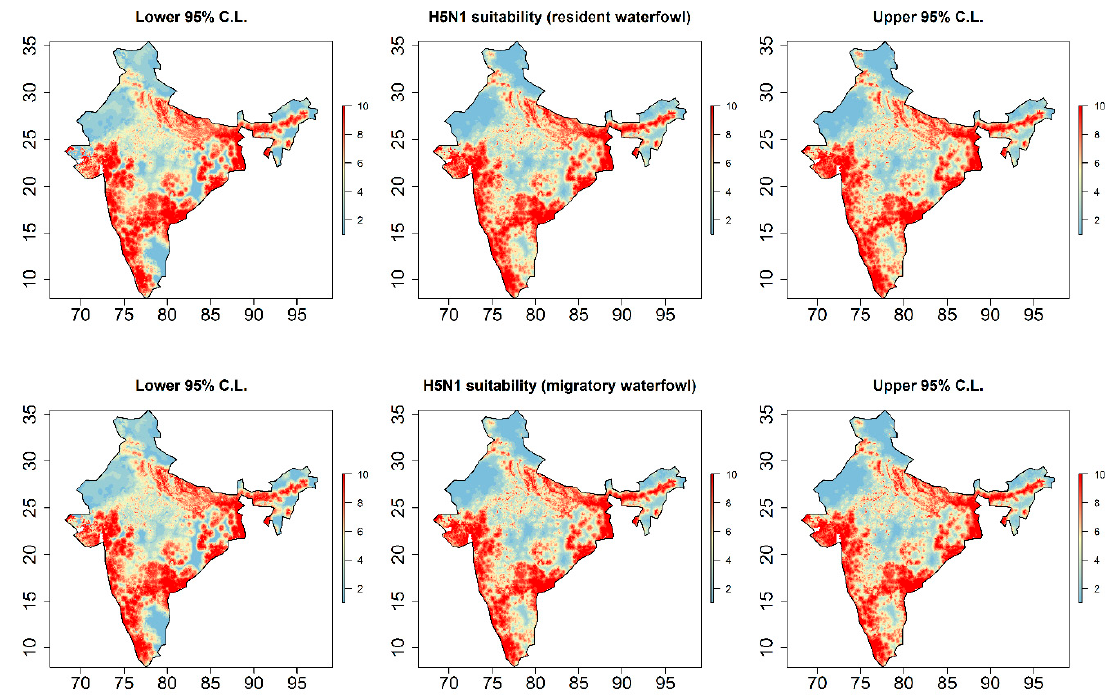
Figure 3. Highly pathogenic avian influenza (HPAI) virus, subtype H5N1, landscape suitability based on predicted intensity at 2.5 arc-minutes (approximately 5 km). The center panels depict HPAI H5N1 suitability for resident-specific ( top ) and migratory-specific ( bottom ) waterfowl models as deciles of the predicted intensities from the best fitting and performing inhomogeneous Poisson point process models (Table 1; Table S3). The left and right panels depict the lower and upper 95% confidence limits, respectively, for the predicted intensities. Map axes represent degrees of longitude ( x -axis) and latitude ( y -axis). All maps are displayed only for the purposes of depicting the distribution of disease occurrence and risk, and do not reflect the authors’ assertion of territory or borders of any sovereign country including India.